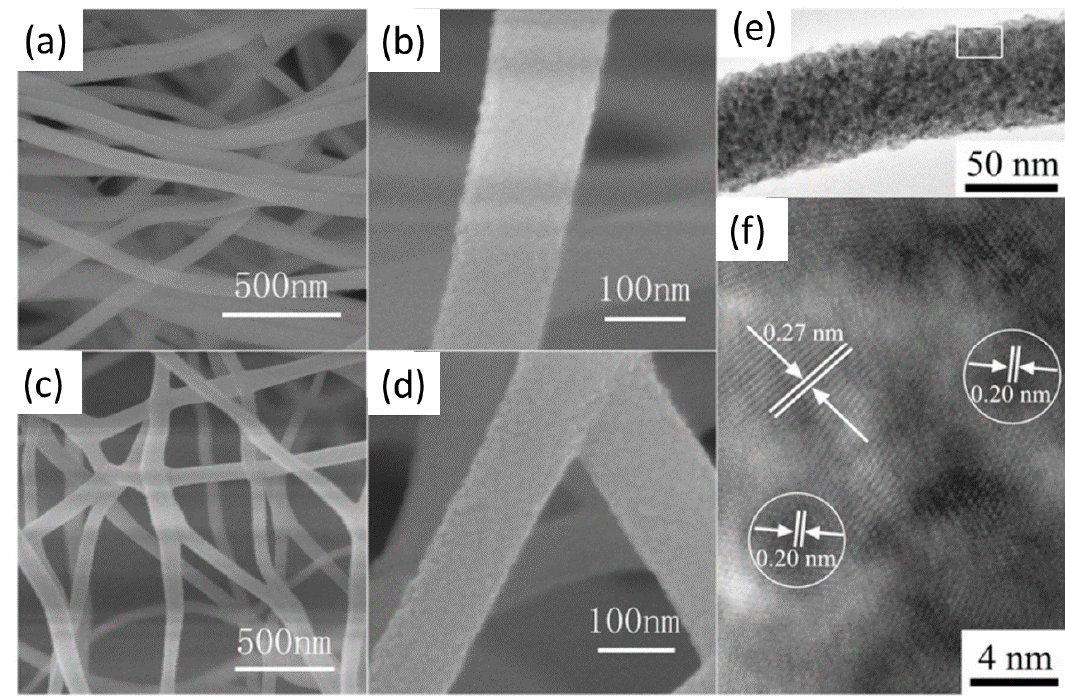
Figure 4. SEM ( a – d ) and HR-TEM images ( e , f ) of CeO 2 ( a , b ) and Pt / CeO 2 ( c – f ) nanofibers, adapted from [31], with permission from Elsevier, 2012.